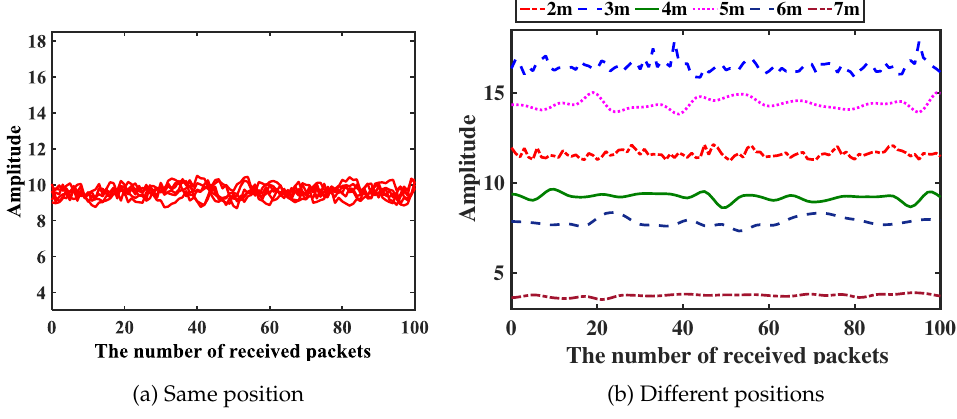
Figure 5. CSI measurements for different